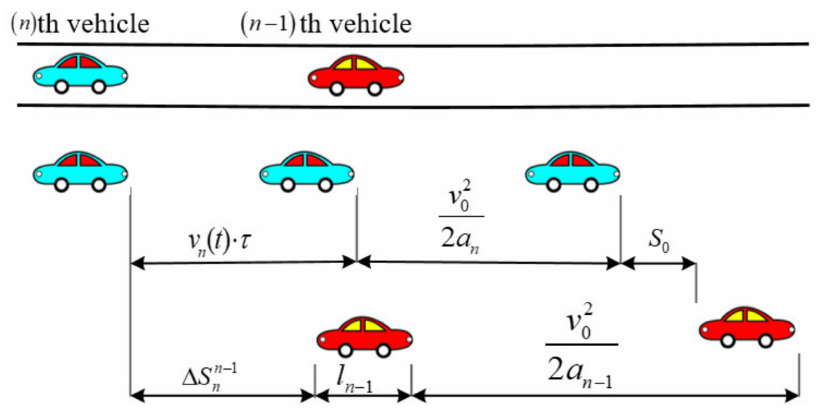
Figure 2. Braking process between two successive vehicles during a car-following